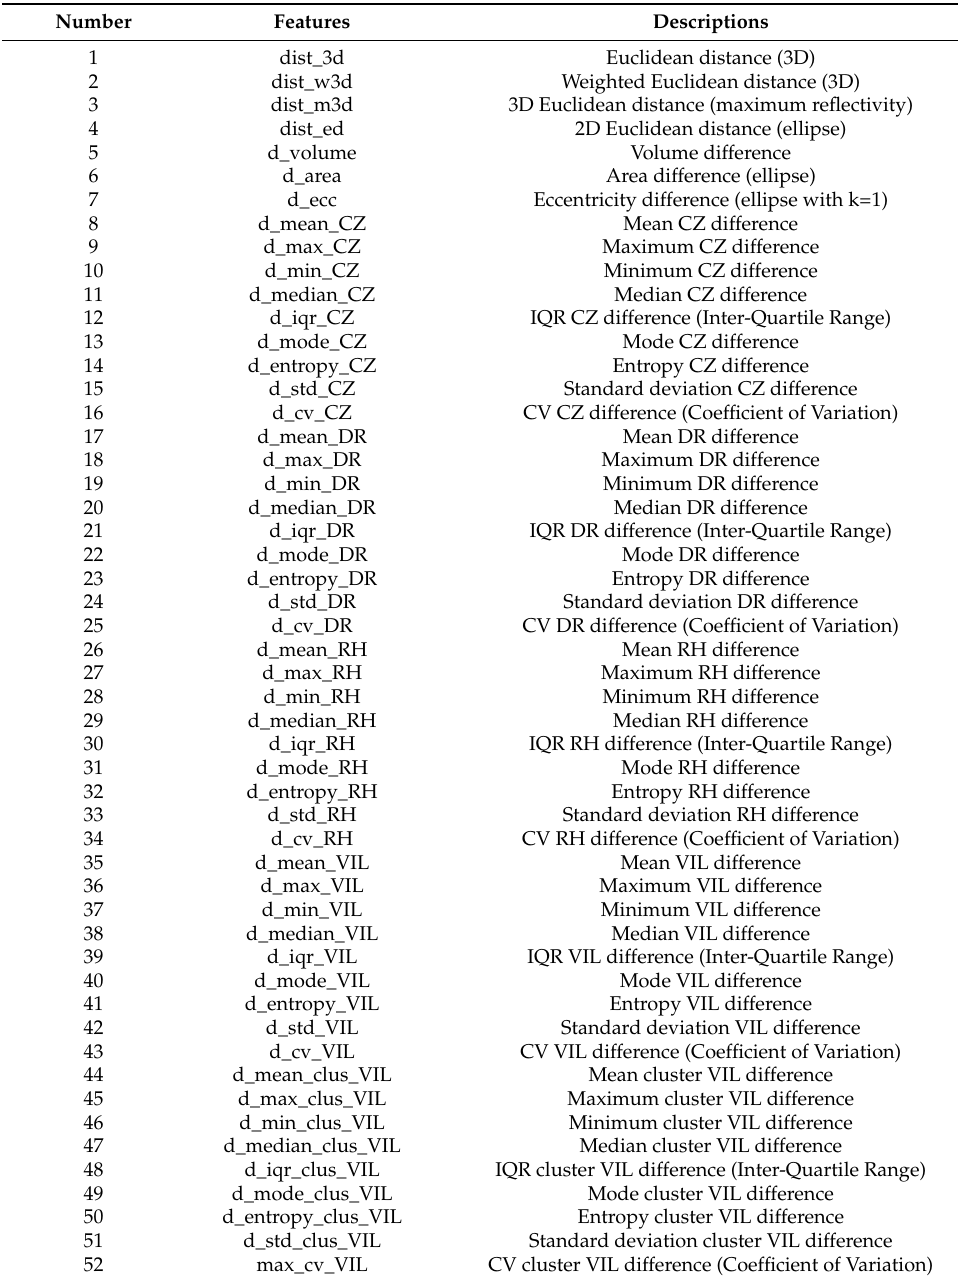
Table 2. The extracted temporal features from consecutive convective storms between ( t ) and ( t − 1 )